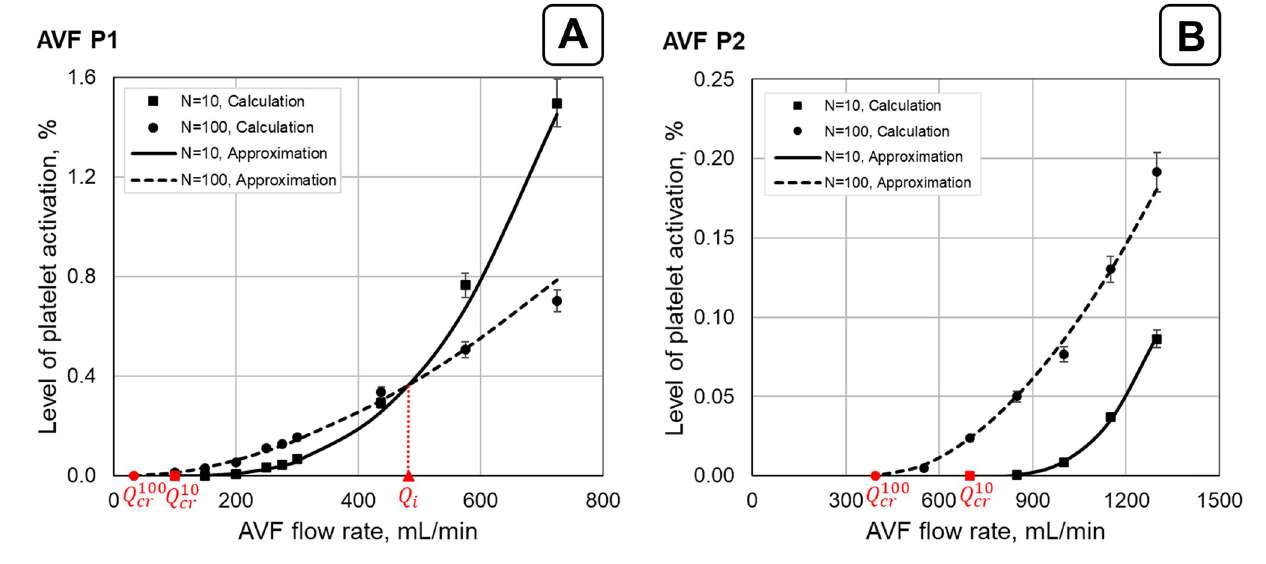
Fig 5. Dependence of the SIPAct level on the flow rate for two multimer sizes in patient-specific AVFs. The calculation results for P1 and P2 AVFs are shown in graphs (A) and (B), respectively. The calculated points are obtained for VWF multimer sizes ( N ) of 10 and 100. The approximation curves (Eq (10)) are represented by the solid ( N = 10) and dashed ( N = 100) lines. Q the critical values of the flow rate through the fistula vein below which SIPAct was not observed for VWF multimer sizes of 10 and 100, respectively. The calculation results for intermediate values of the VWF multimer size are given in S6 Text.